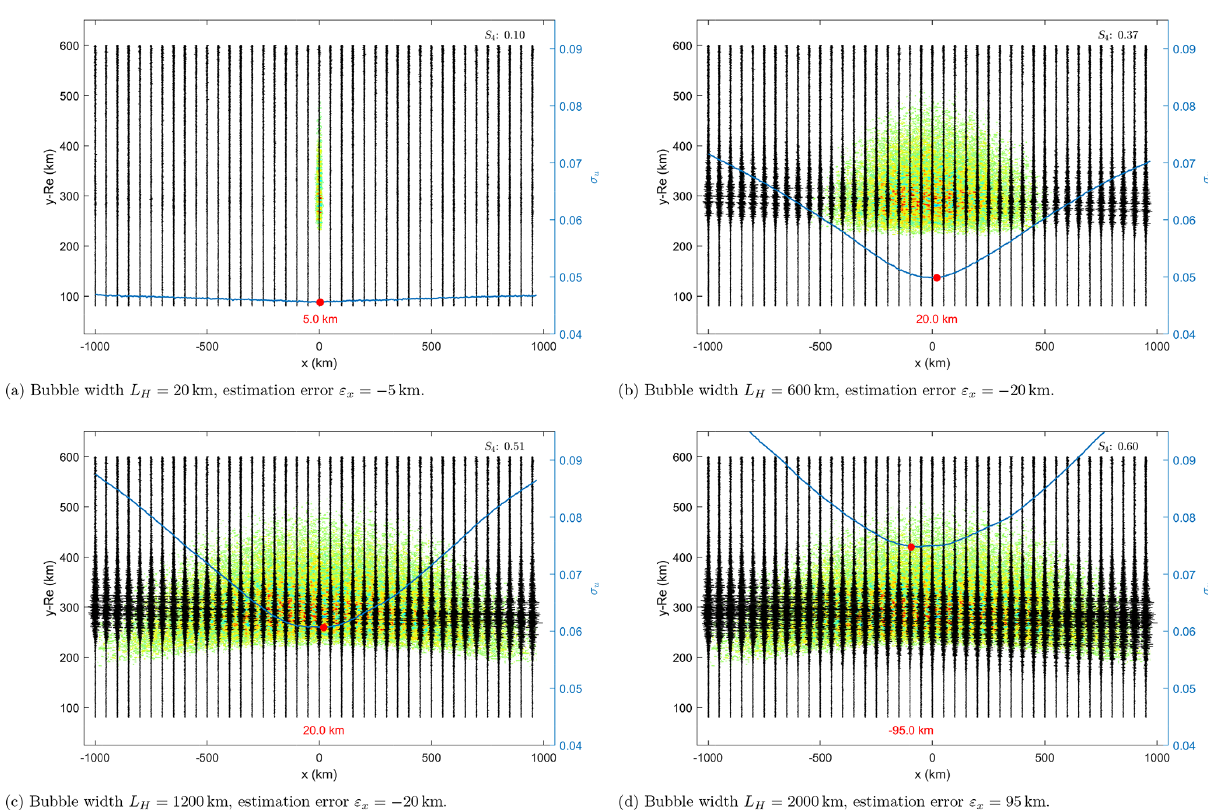
Figure 10. Single bubble with different widths ( L H ). The detection is possible for wide regions, but estimate accuracy decreases with increasing width.